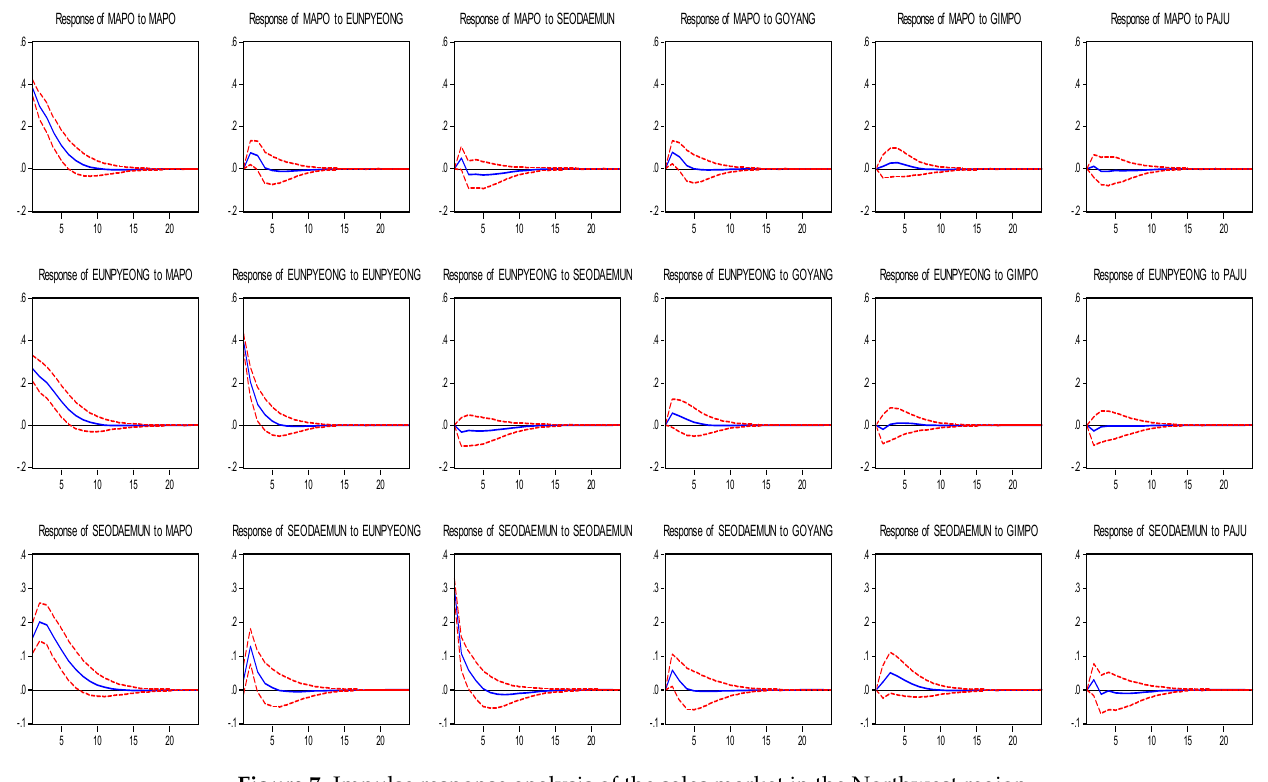
Figure 7. Impulse response analysis of the sales market in the Northwest region. According to the previous result, the change in the jeonse price was greatly affected by Goyang in the Gyeongeui region, however, Goyang exerted relatively little influence on the change in sales prices. Moreover, the influence of Eunpyeong in the Northwest region was relatively significant (see Figure 8).